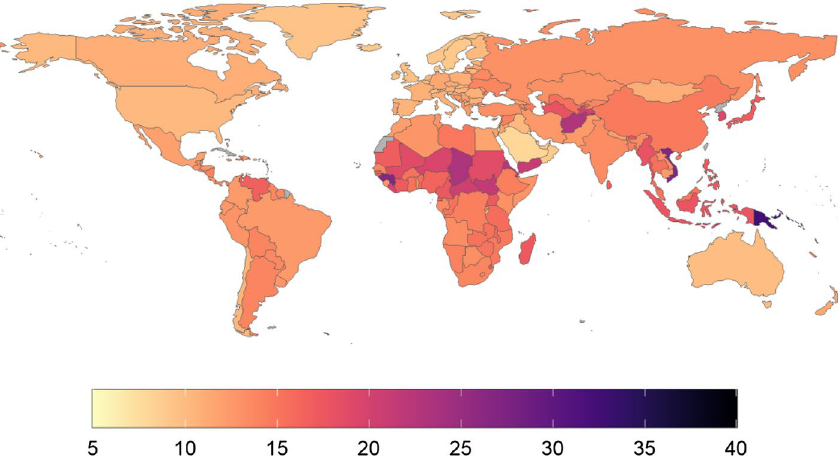
Figure 3. Heatmap of minutes of average daily playtime per active user (MDP), Oct 2020–2021. Countries/ regions with no data in grey colour. This map was generated using ggplot in R (v4.0.2). Code for reproducing these maps is available at the OSF repository associated with the project.